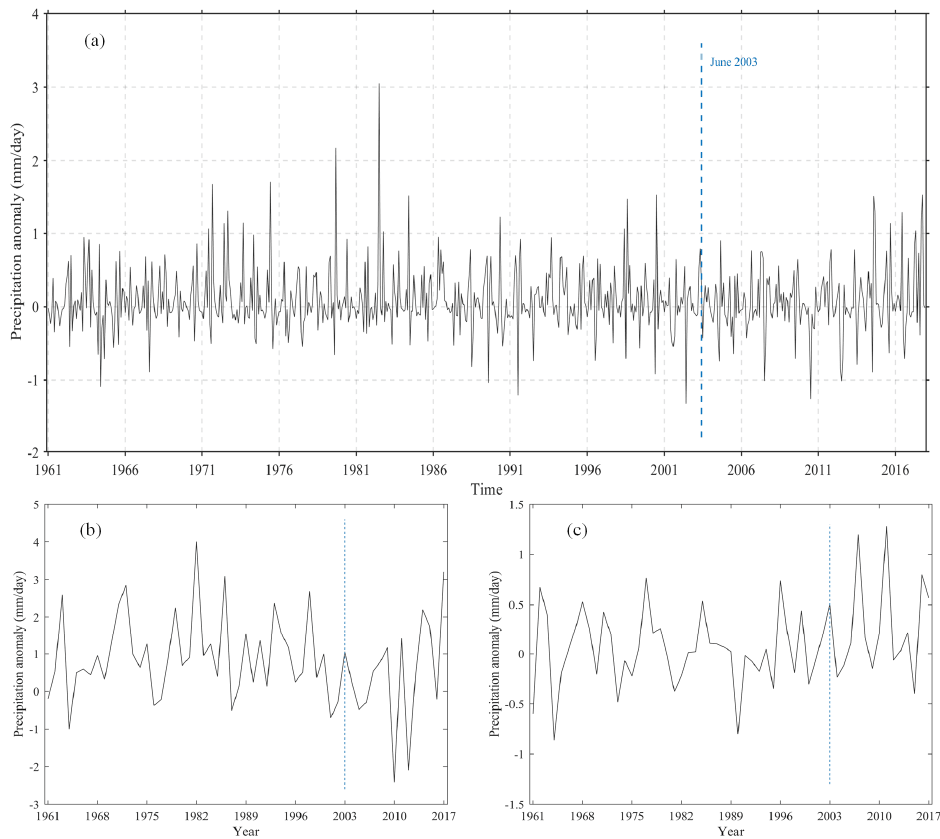
Figure 10. The change of ( a ) mean monthly precipitation anomaly, ( b ) flood season precipitation anomaly, and ( c ) dry season precipitation anomaly in the TGRA from 1961 to 2017.